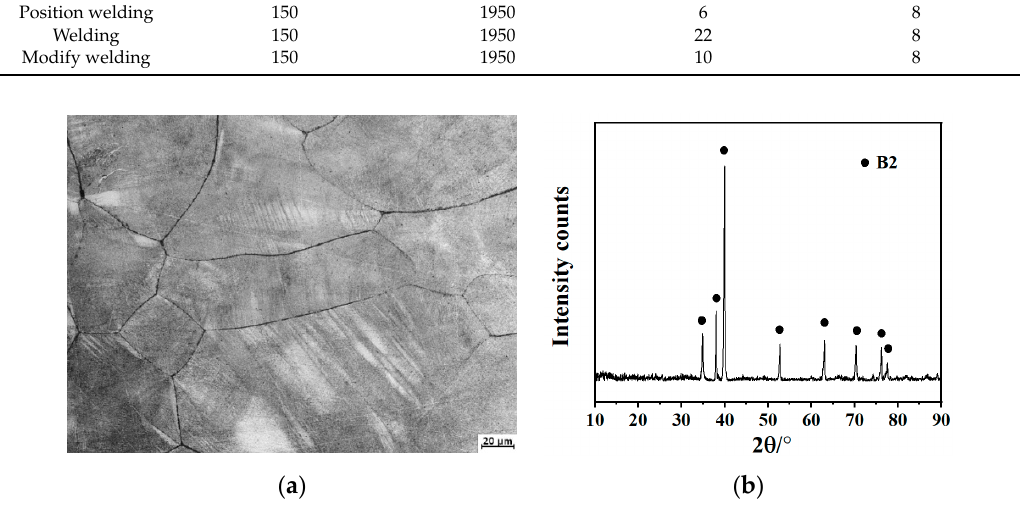
Figure 2. ( a ) Microstructure and ( b ) XRD of the Ti600/Ti-22Al-25Nb welded joint. Table 1. Electron beam welding parameters of Ti600/Ti-22Al-25Nb specimens.